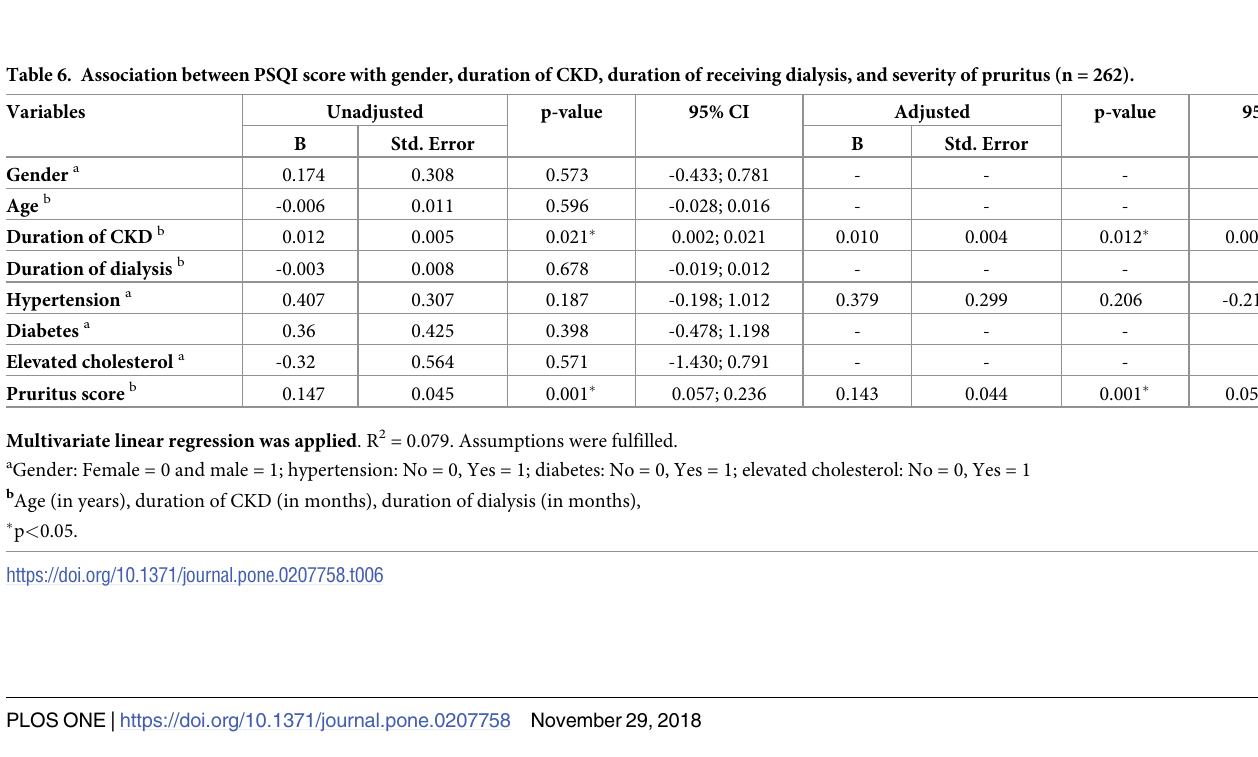
Duration of CKD